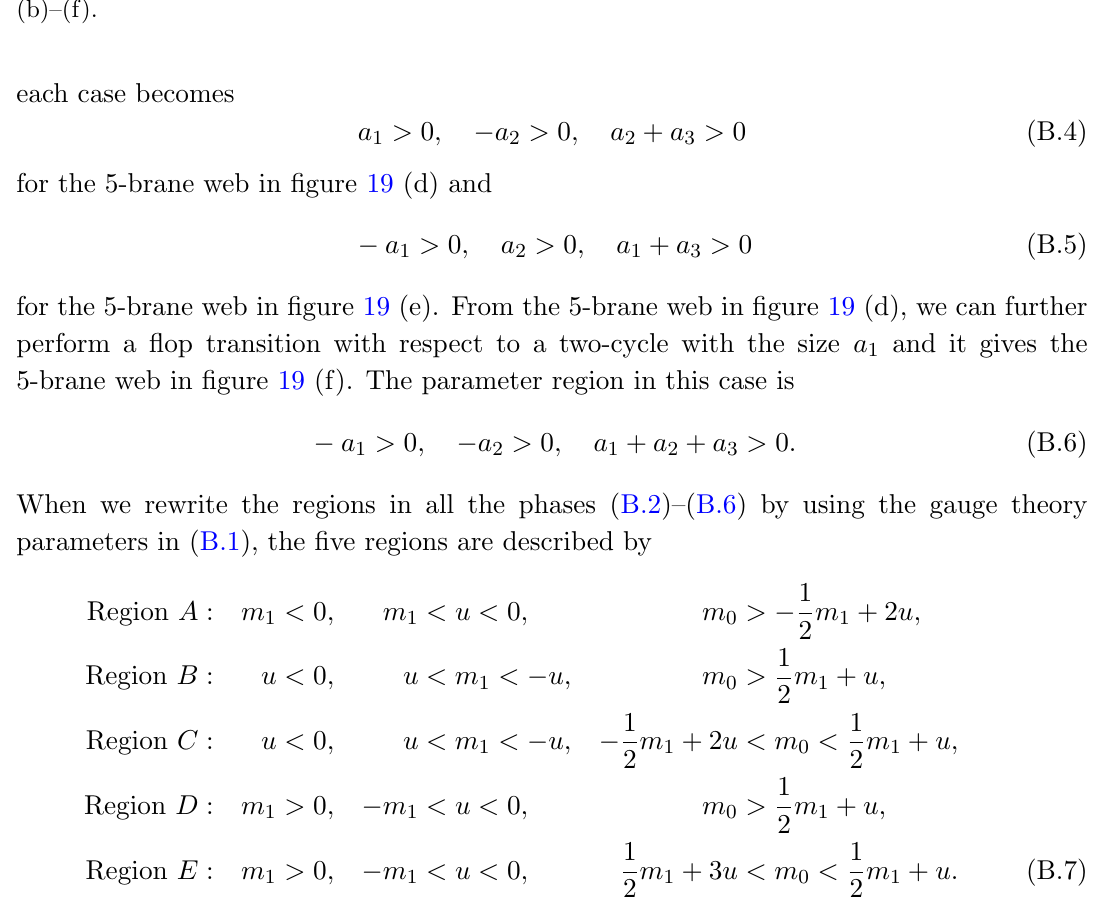
Table 9. The e(cid:11)ective coupling for the E 2 theory realized by the 5-brane web diagrams in (cid:12)gure 19